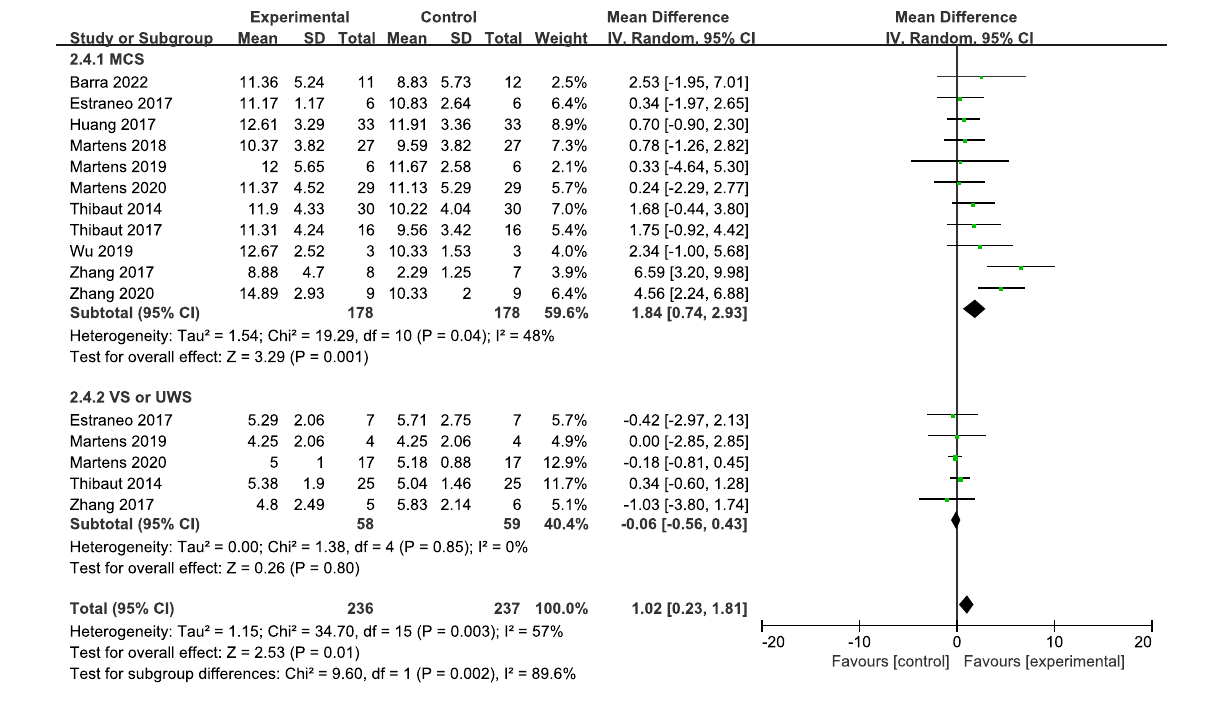
FIGURE8 Subgroup analysis of patient diagnosis on GCS scores in patients with DOC.